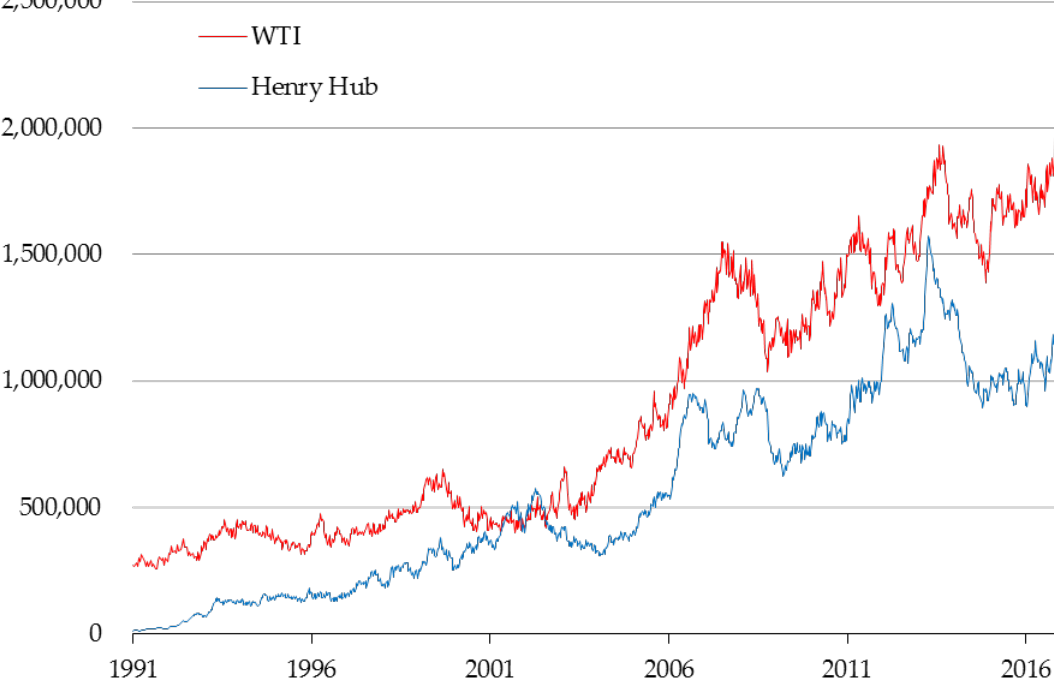
Figure 1. Open interests of WTI futures and Henry Hub futures.